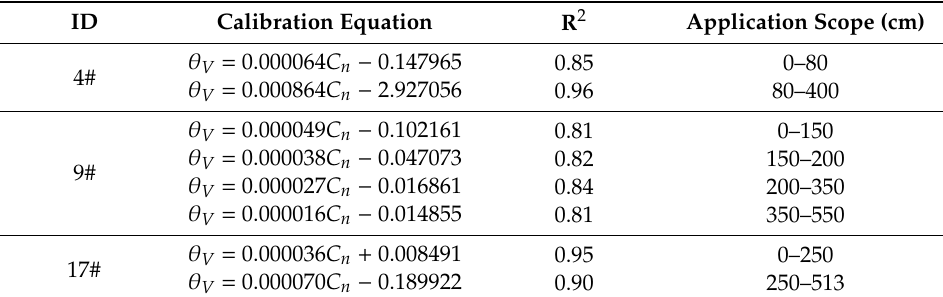
Table 1. Piecewise grading formula of the neutron moisture meter of each observing points.